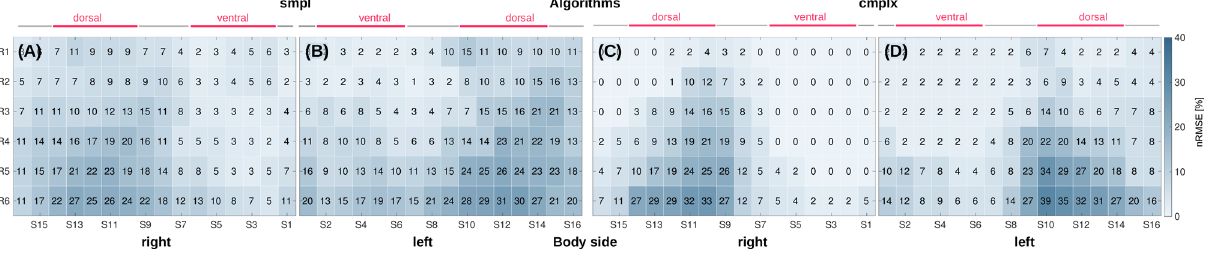
Stride duration algorithm performance in athlete study. Figure 6 shows nRMSE maps of the marker stride dura- tion and sensor positions at the upper legs averaged across all athletes. In general, the cmplx algorithm yielded wider area with low nRMSE compared to the smpl algorithm. SI Figure S11 (see supplementary material) shows the nRMSE maps for both algorithms and a selected athlete. Case study 2: Walking patients after stroke.